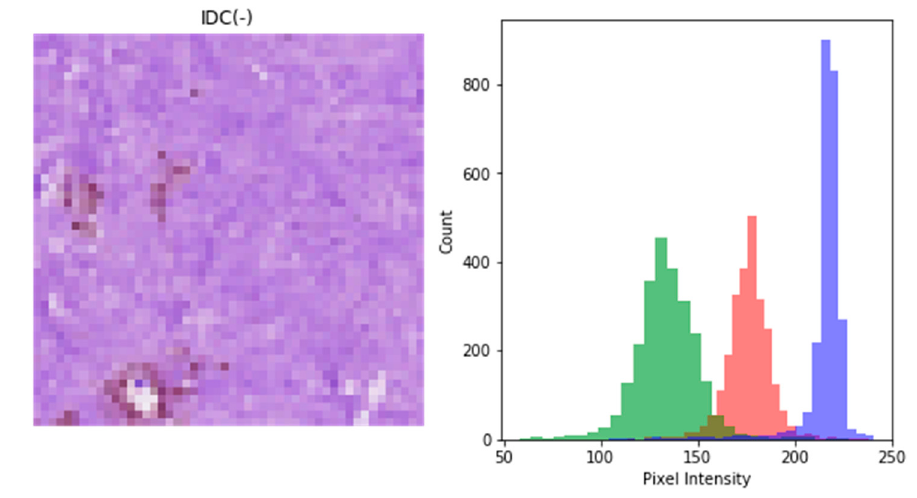
Figure 4. Visualization of the pixel intensity of the sample image in the form of RGB channels.